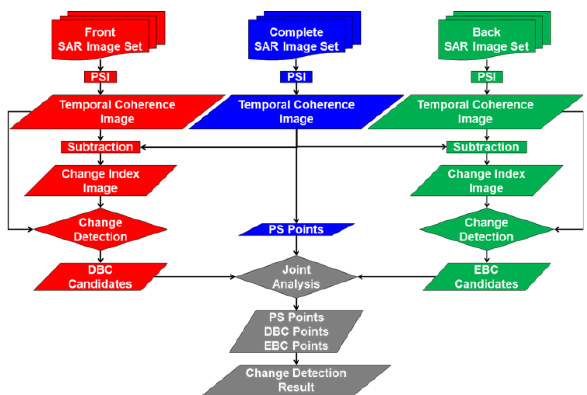
Figure 1. Flowchart of single-break-date change detection. Persistence (blue), disappearance (red), and emergence (green) scenarios are dedicated to extracting PS, DBC, and EBC points,